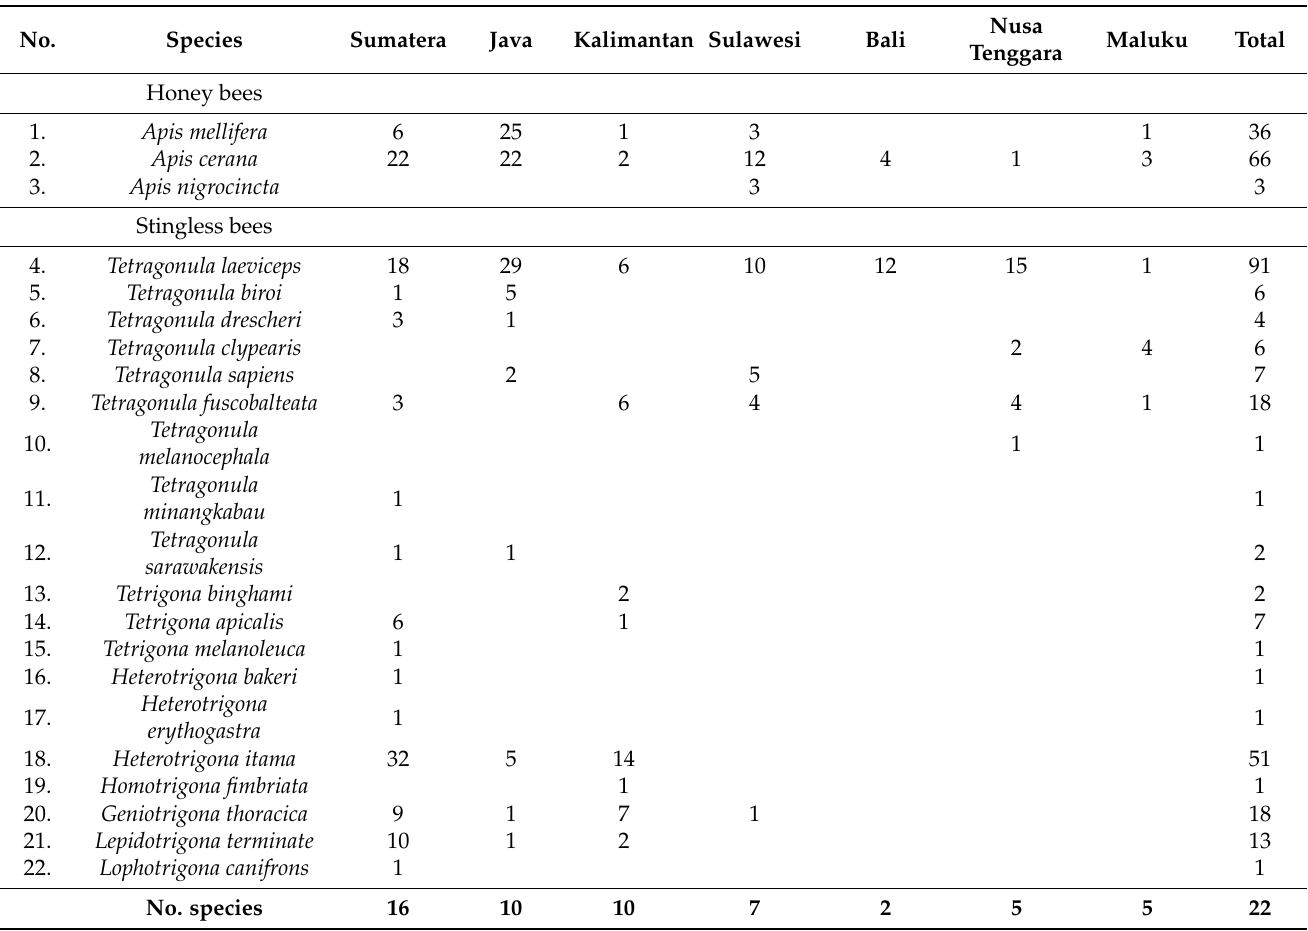
Table 2. Diversity of honey bees and stingless bees that are reared by beekeepers in different islands in Indonesia. The numbers indicate the number of respondents ( n = 221), and some respondents may have several bee